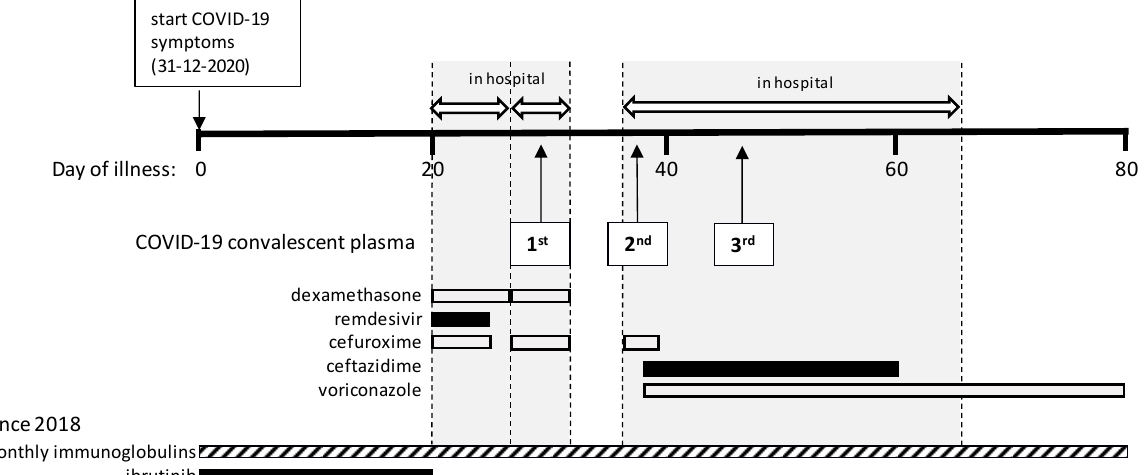
Figure 1. Timeline of a patient with CLL and prolonged COVID-19.